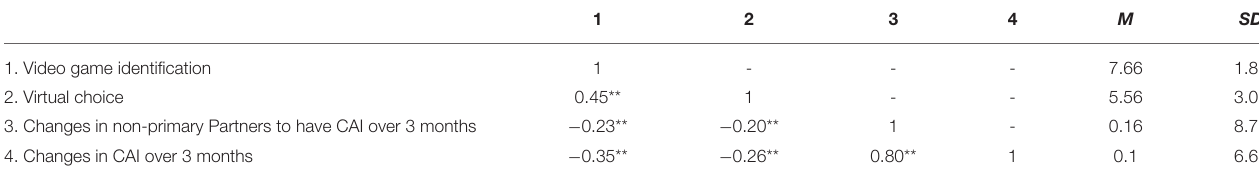
TABLE 1 | Bivariate correlations of variables of interests.